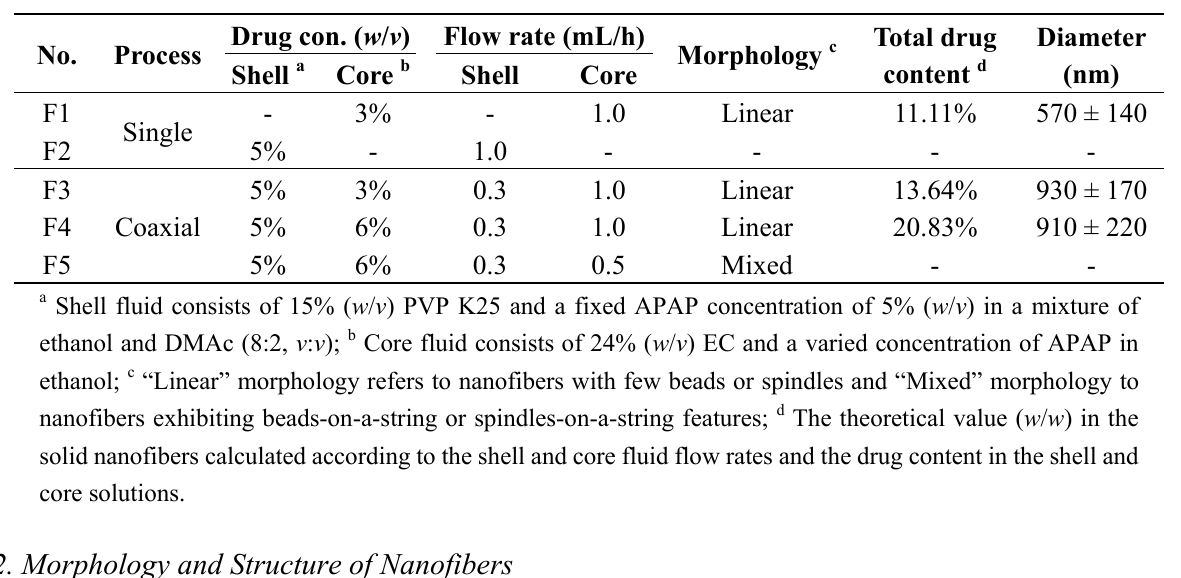
Table 1. Parameters used for electrospinning and details of the nanofiber